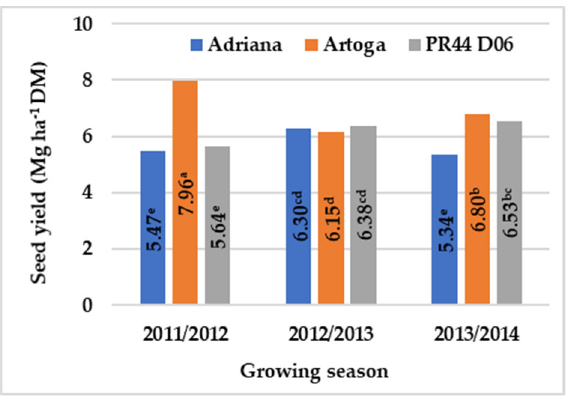
Figure 1. Seed yield of winter oilseed rape cultivars, across growing seasons (2011–2014). Means with the same letters do not differ significantly at p ≤ 0.05 in Tukey`s test.